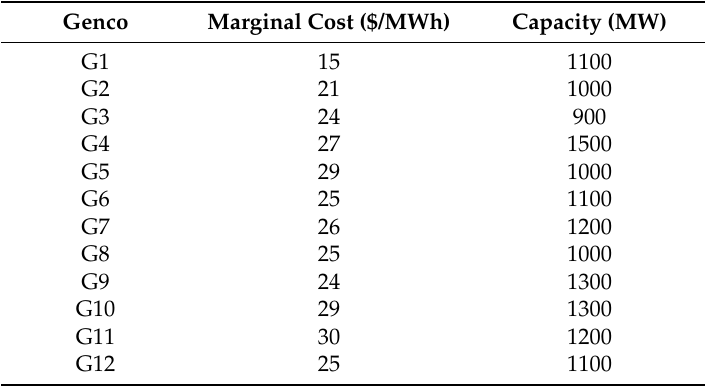
Table A1. Generation side data in an 18-bus network.